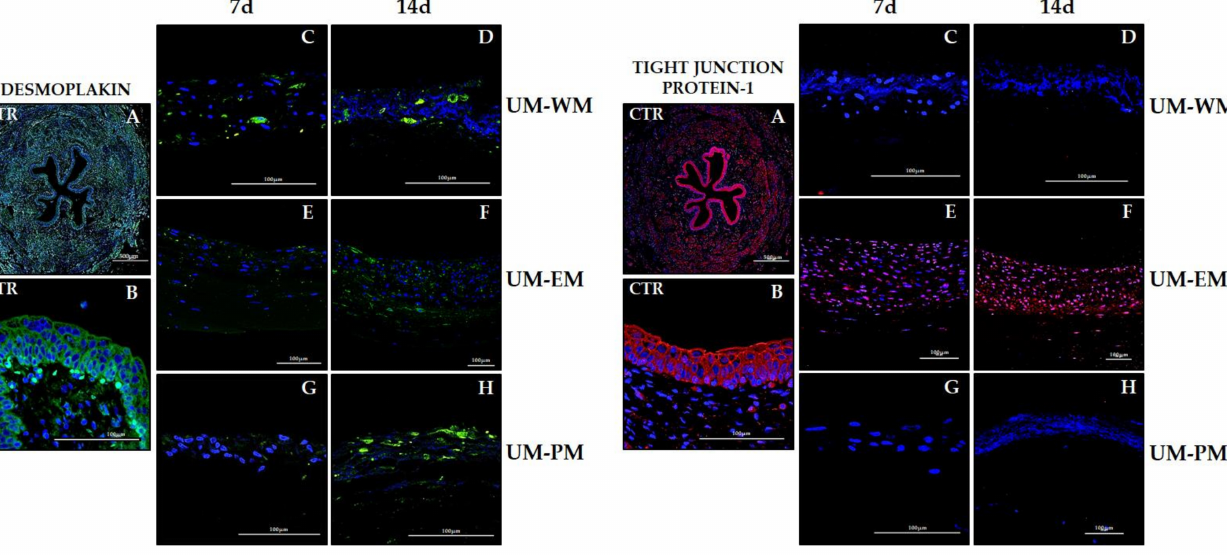
Figure 7. Immunofluorescence analysis of desmoplakin and tight-junction protein-1 (TJP1) in control human UM (CTR) and tubularized heterotypical substitutes of the human UM cultured with three different media (WM, EM, and PM) for 7 and 14 days. Scale bars: 500 µ m in ( A ) and 100 µ m in ( B – H )